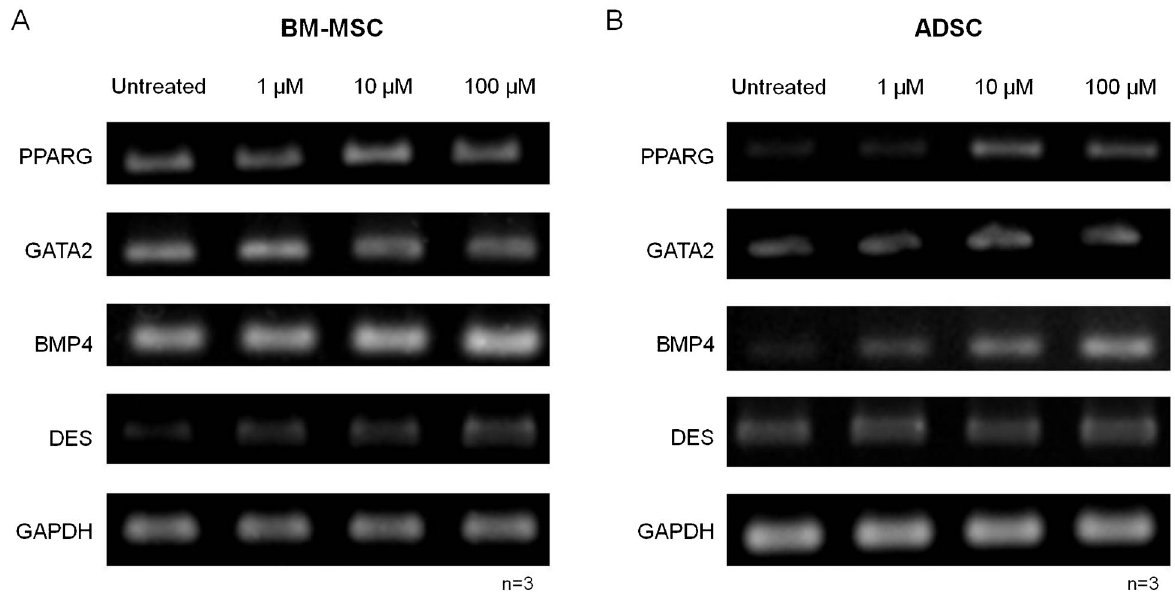
Figure 6. Effect of 5-aza-2 9 -deoxycytidine (5azadC) treatment (1, 10 and 100 m m) on gene expression in MSCs. PPARG, GATA2, BMP4, and DES (desmin) were analyzed by RT-PCR after 2 days of treatment. GAPDH was used as control. MSCs = mesenchymal stem cells; BM-MSCs = bone marrow MSCs; ADSC = adipose tissue stem